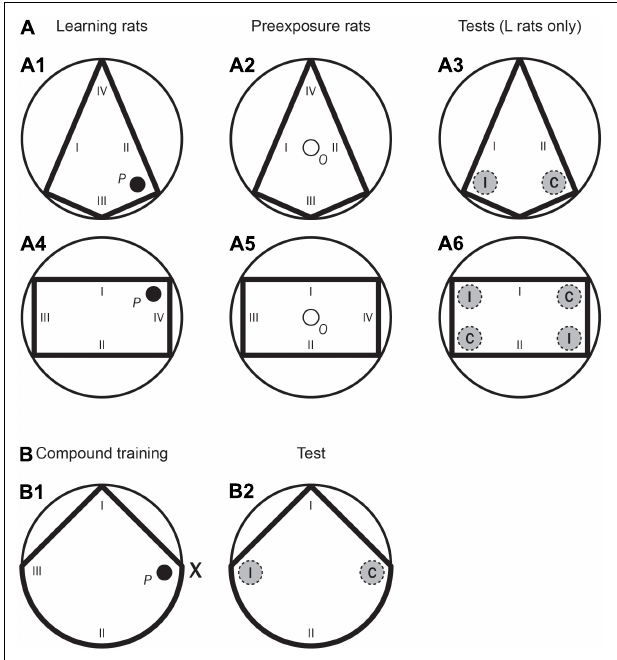
FIGURE 1 | Experiment 1. ( A: A1) A schematic representation of the kite shaped pool, as well as the position of the hidden platform ( P ) and the starting positions (I–IV) used in the first training phase for Groups LPE and SPE (Learning rats). (A2) A schematic representation of the kite shaped pool as well as the position of the observation compartment ( O ), and the starting positions (I–IV) used in the first training phase for Groups LPE and SPE (Preexposure rats). (A3) A schematic representation of the kite shaped pool, as well as the two recording areas (correct and incorrect, C and I, respectively) and the starting positions (I, II) used in the test trial for rats in Groups LPE and SPE. (A4) A schematic representation of the rectangular pool as well as the position of the hidden platform ( P ), and the starting positions (I–IV) used in the second training phase for Groups LPE and SPE (Learning rats). (A5) A schematic representation of the rectangular pool as well as the position of the observation compartment ( O ), and the starting positions (I–IV) used in the second training phase for Groups LPE and SPE (Preexposure rats). (A6) A schematic representation of the rectangular pool, as well as the four recording areas (two correct and two incorrect, C and I, respectively) and the starting positions (I, II) used in the test trial for rats in Groups LPE and SPE. ( B: B1) A schematic representation of the triangular pool and the position of the landmark, X, as well as the position of the hidden platform ( P ), and the starting positions (I–III) used in the compound training phase for all rats. (B2) A schematic representation of the triangular pool, as well as the two recording areas (correct and incorrect, C and I, respectively) and the starting positions (I, II) used in the test trial for all